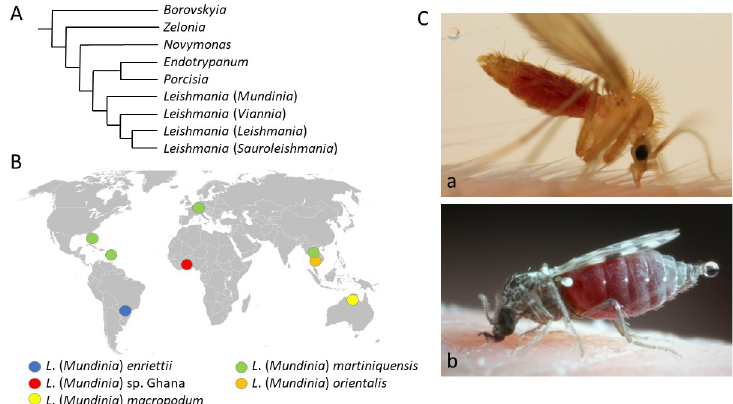
Fig 1. (A) Phylogenetic relationships of the four genera of the subfamily Leishmaniinae and subgenera of the genus Leishmania , based on [3,6,37].(B) Geographical distribution of L . ( Mundinia ) species, based on [4–5,7–8,10,14–17]. The blank map source - https://commons.wikimedia.org/wiki/Atlasof the_world/. (C) Female sand fly Phlebotomus duboscqi feeding on the mouse demonstrating prediuresis which allows rapid concentration of proteins and restoring water and weight balance (a) and Culicoides biting midge feeding on a human host while also performing prediuresis